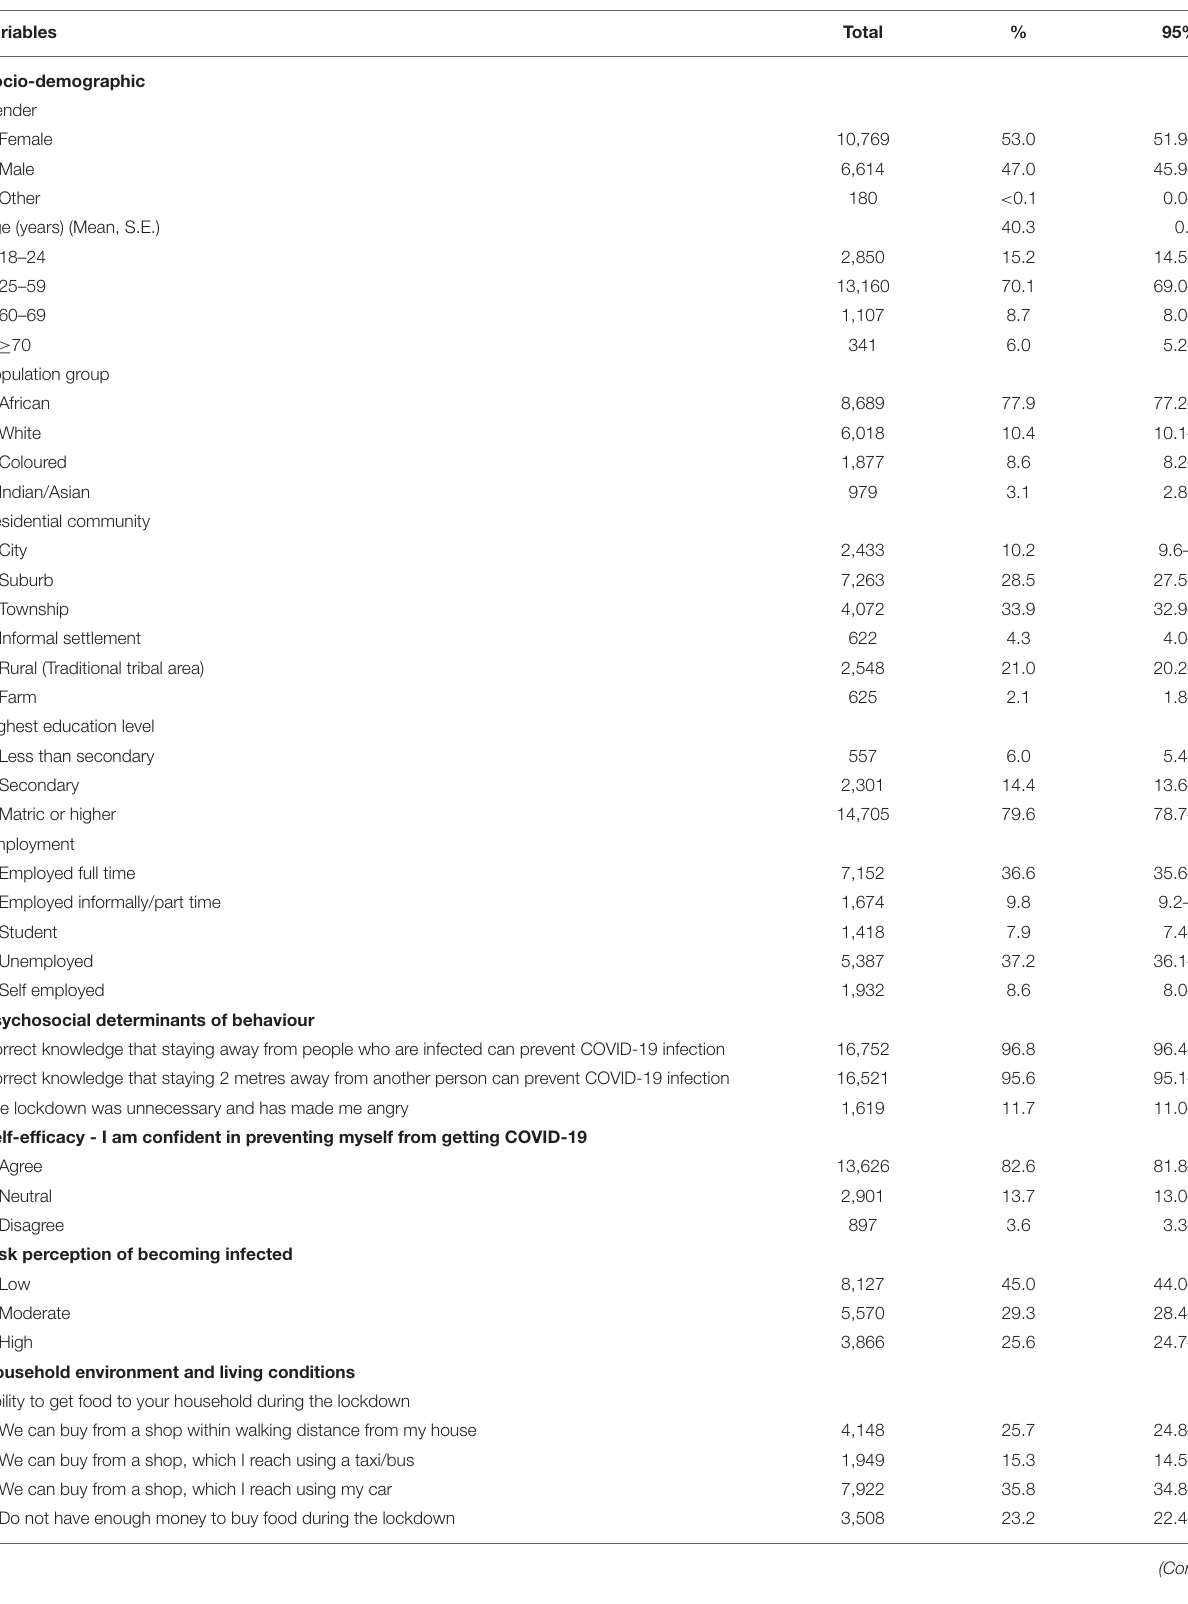
TABLE 1 | Characteristics of the study